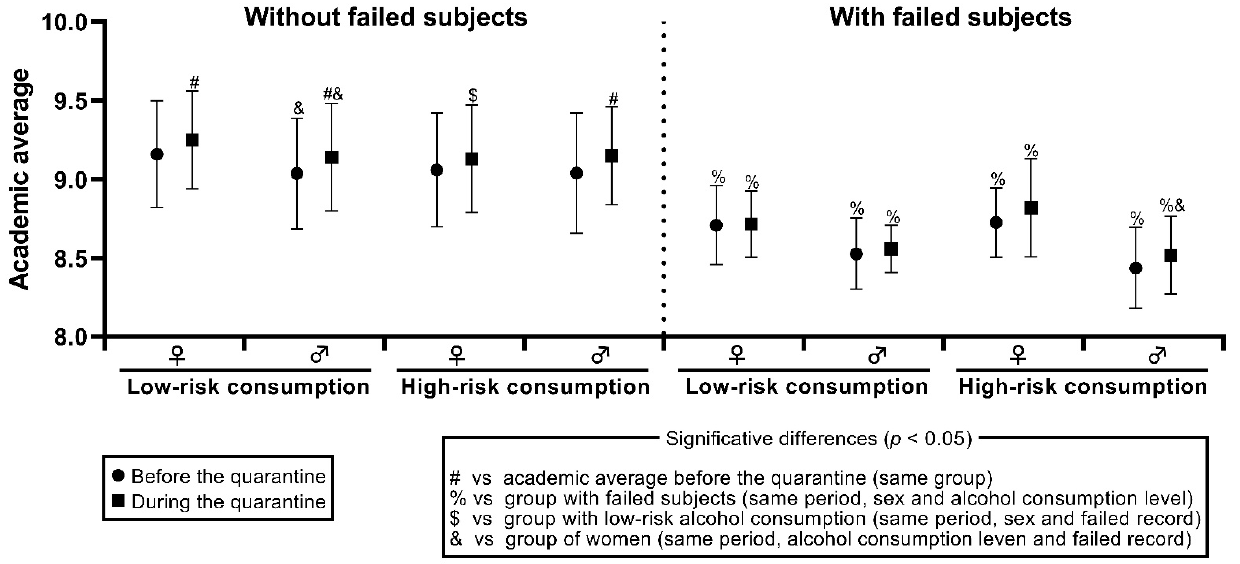
Figure 1. Comparison of the academic average of the students, according to their failed record, al ‐ cohol consumption level, sex, and assessment period. Results are shown as main and standard de ‐ viation.